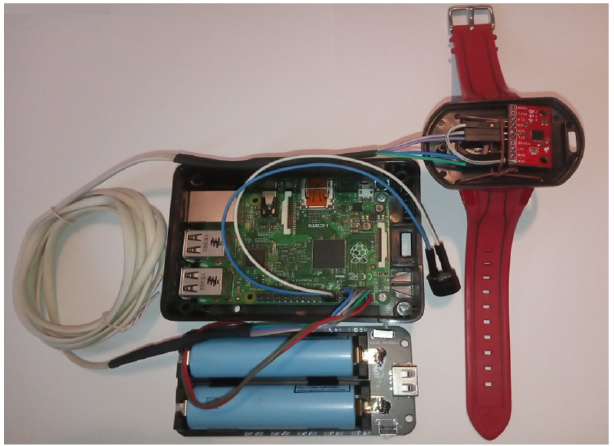
Figure 3. The experimental equipment with the SparkFun MPU6050 accelerometer, gyro sensor, and the Raspberry-Pi minicomputer.